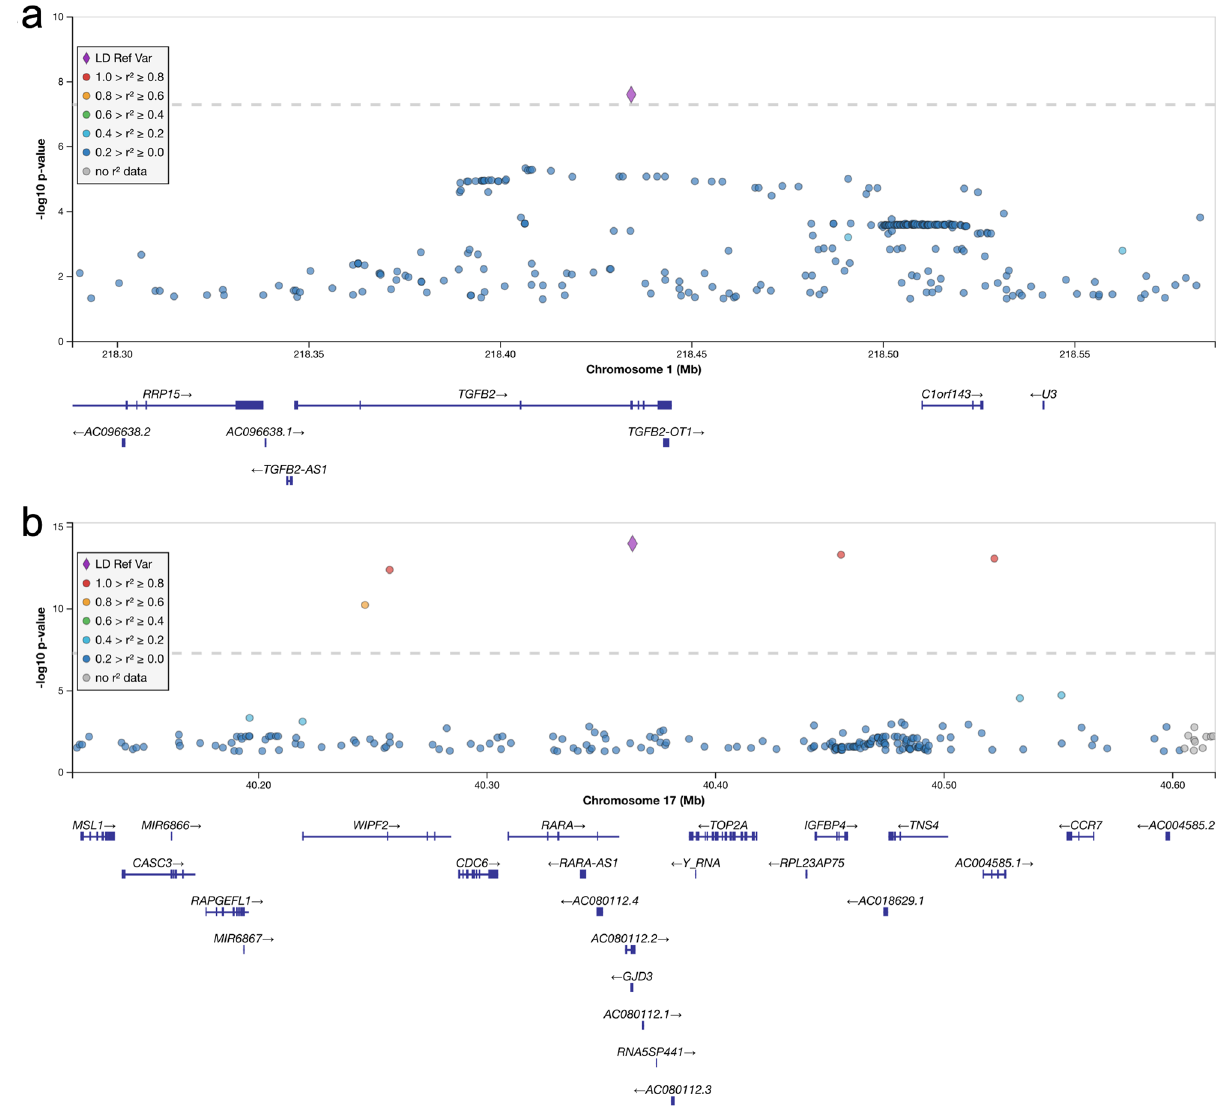
Fig. 4 Volcano plots of TGFB2 and GJD3 lead SNP PheWASs. The disease event associations of the phenome-wide scan of rs192335285-T ( TGFB2 ) in a and rs201955556-T ( GJD3 ) in b are plotted with their − log 10 -transformed P values and the associated effect ( β ) as the logarithm of the odds ratio along the vertical and horizontal axes, respectively. The categories of the 1706 analyzed disease events are indicated according to the legend right of the fi gure. Phenome-wide signi fi cant ( P < 6.1 × 10 − 7 ) disease endpoint associations have been annotated with their disease endpoint